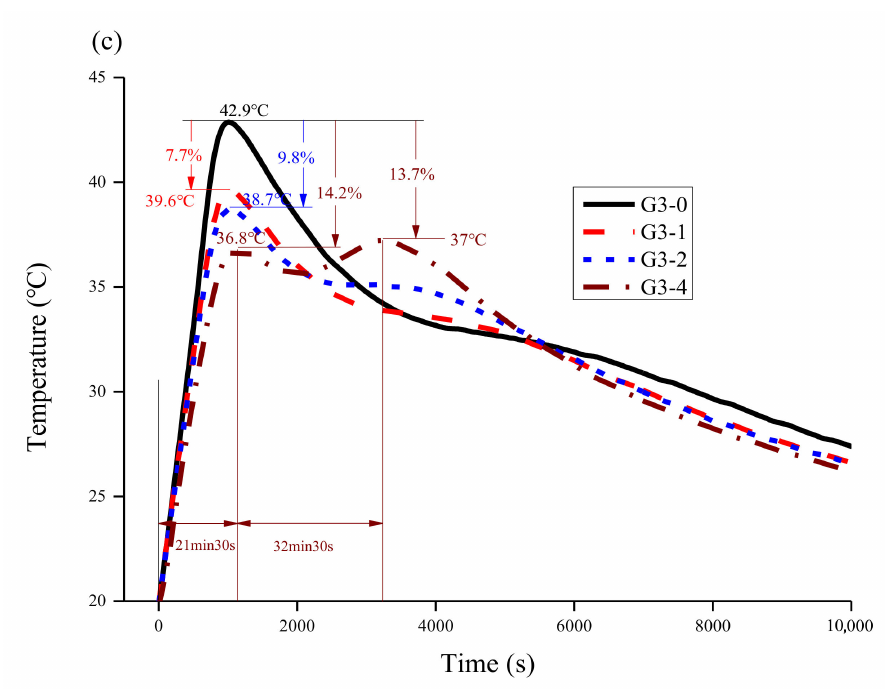
Figure 3. Hydration heat of the MKPC specimens as a function of glass powder content (0, 10, 20, and 40 wt.%) and M/P ratio of ( a ) 1:1, ( b ) 2:1, and ( c )